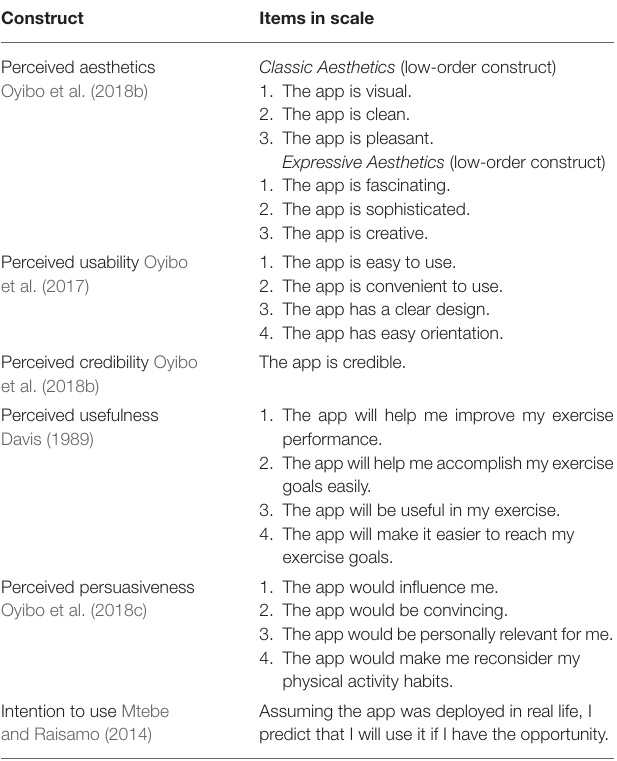
TABLE 1 | Empirical scales employed in measuring the TAM-based UX design constructs. Construct Items in